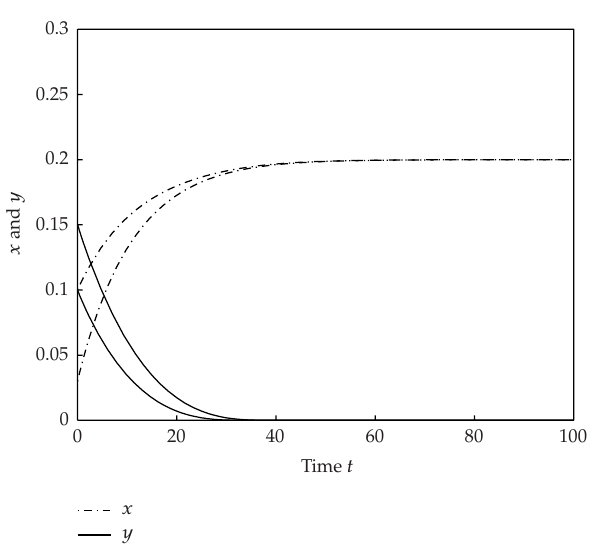
Figure 4: Solution curves for R 0 (cid:8) 0 . 25 with initial value (cid:5) 0 . 03 , 0 . 1 (cid:6) , (cid:5) 0 . 1 , 0 . 15 (cid:6) .